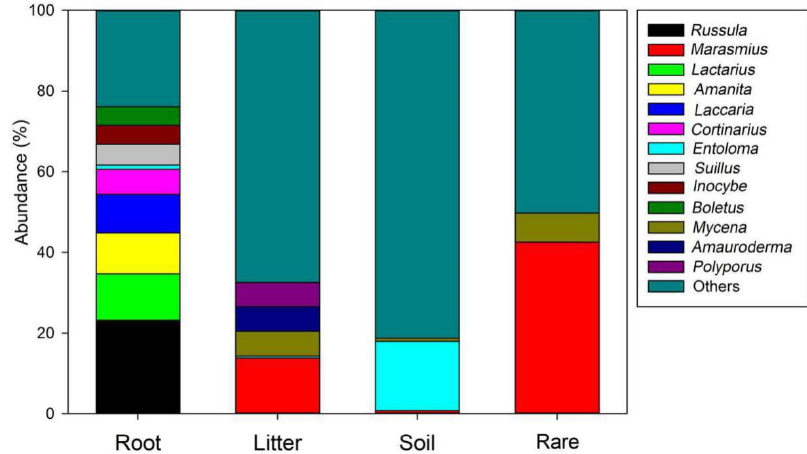
Figure 2. Relative abundances of dominant macrofungal genera collected in the GMS (Zhongdian, Baoshan, Mengsong, Thailand, and Laos) for each substrate category (root, litter, soil, and rare). Table 2. The classification of macrofungal species growing on each substrate collected in the GMS.